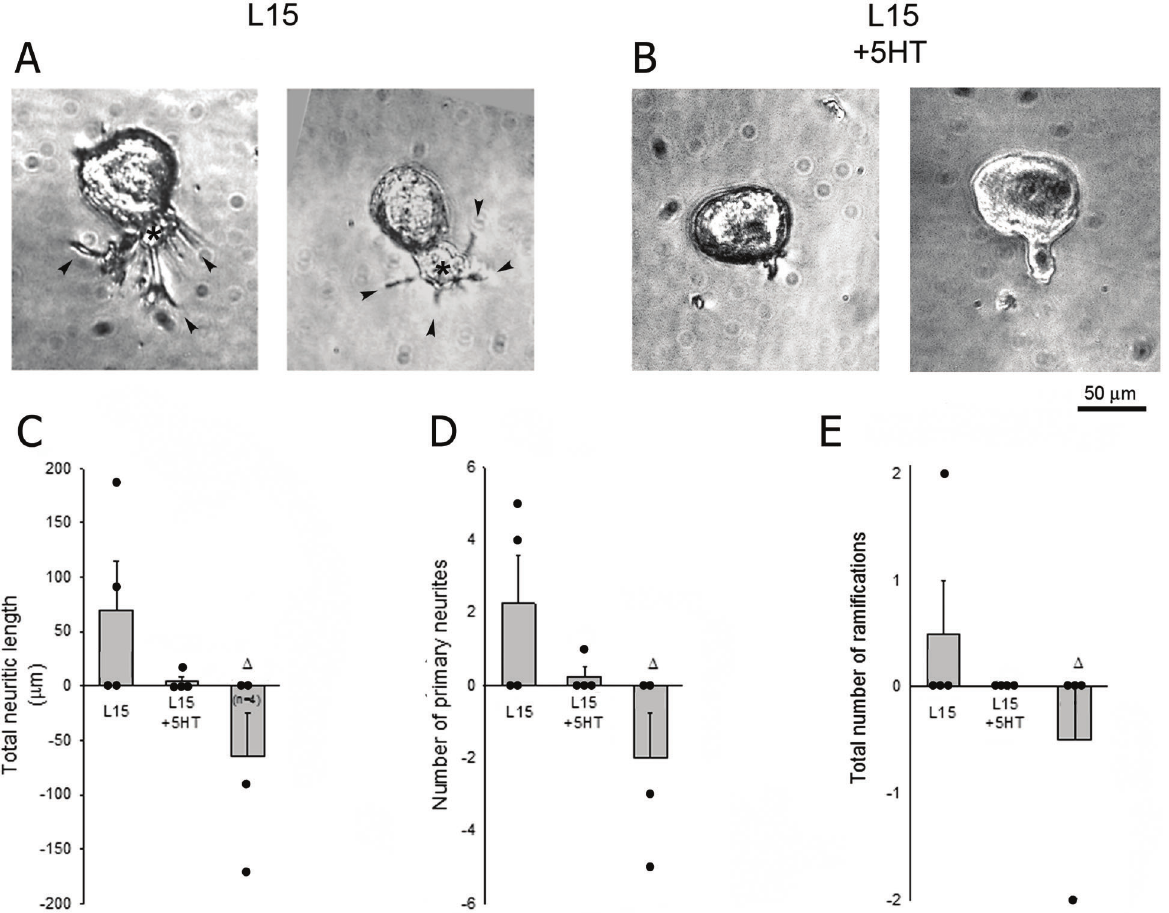
Figure 2. Effect of serotonin (5-HT) on the morphological pattern of Retzius interneurons. A , Upon removal, these neurons maintain a robust stump (asterisks) from which neurites are formed. When cultured on glass plates, their growth is scant, with some primary neurites and few rami fi cations (black arrowheads). B , The presence of serotonin decreased neurite extension and many neurons did not yield neurites or these were even shorter. C – E , In these neurons, serotonin decreased the magnitude of the average total neuritic length, the number of primary neurites, and the number of branches. D denotes the average difference ( ‘ with 5HT ’ minus ‘ without 5HT ’ ) for each pair of neurons from the same experiment. However, given the limited growth occurring in the Retzius neurons under control conditions, these reductions in growth were not statistically signi fi cant (unpaired t -test). Data are reported as means ±